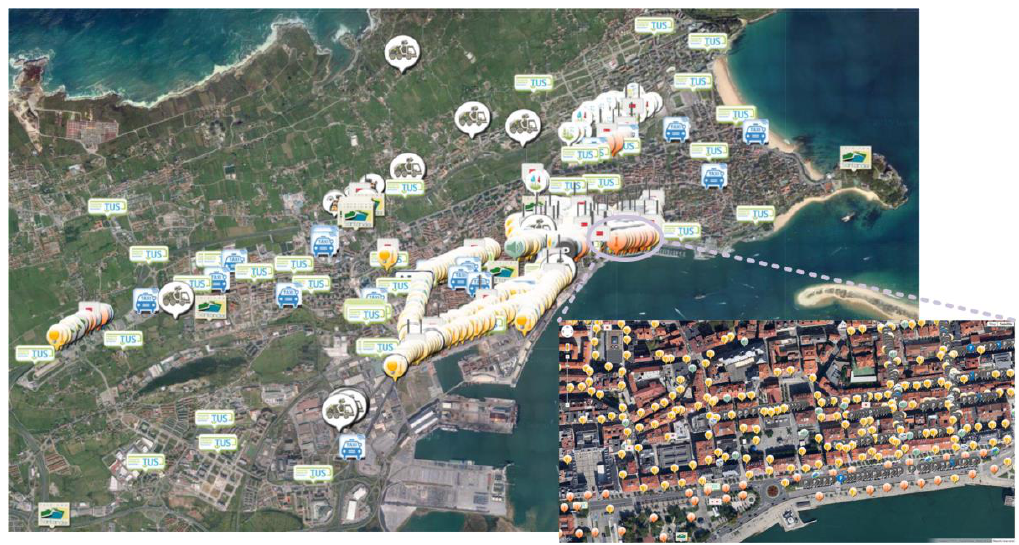
Figure 1. Santander internet of things (IoT) infrastructure deployment excerpt view.